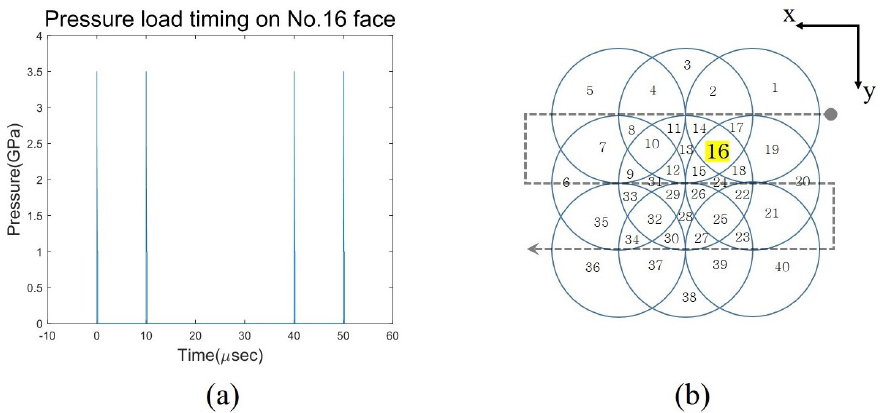
Figure 6. Example of the overlapped multiple LSP pattern; ( a ) Pressure load timing on face No. 16; ( b ) Pressure loading sequence. The gray-colored dotted line indicates the laser pulse path.